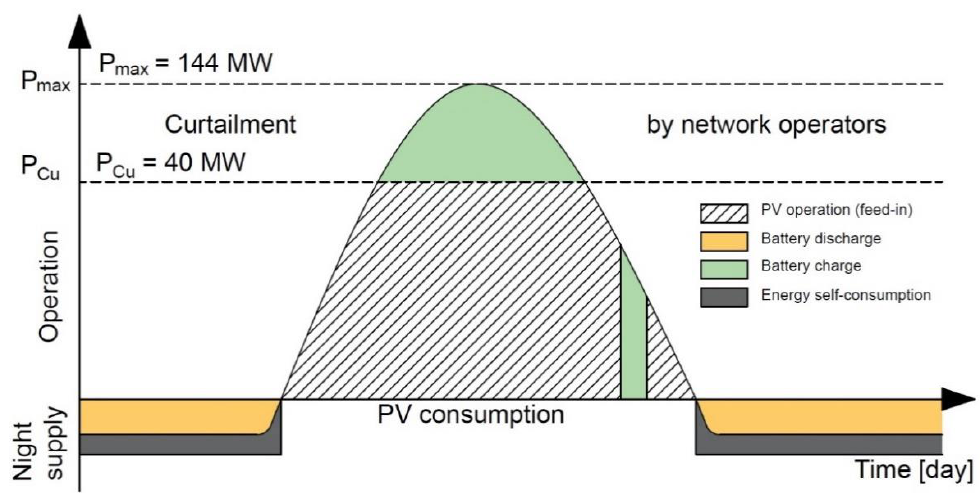
Figure 5. Operation procedure of the PV farm in Germany with BES―study case A. Table 2. Economic data for the adopted model.